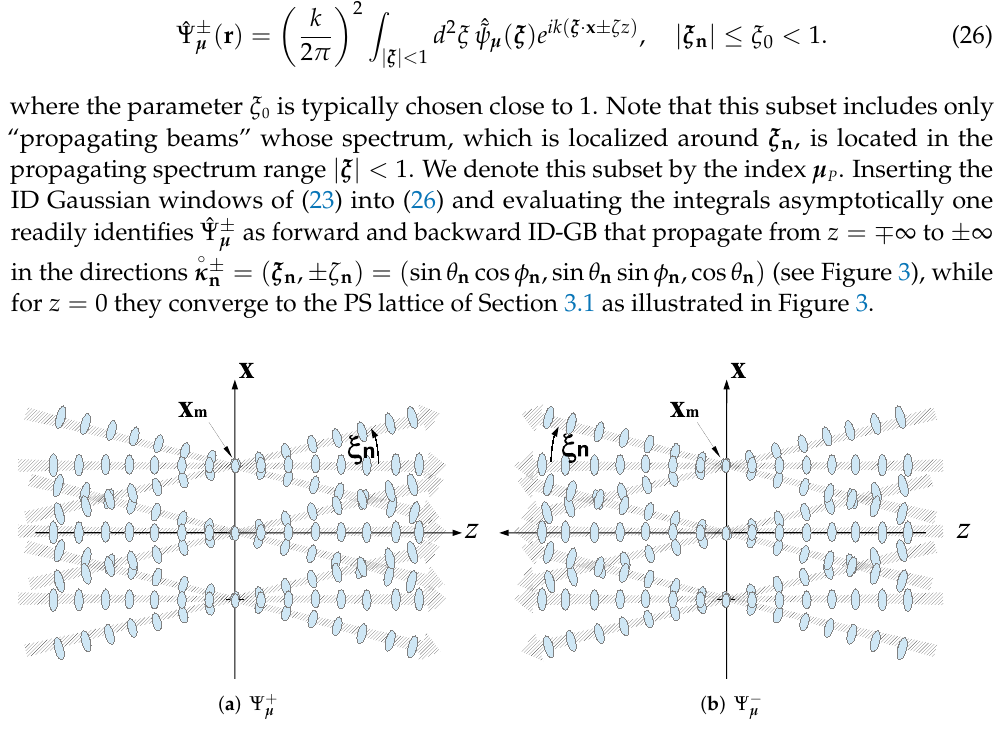
(cid:8) ˆ Ψ ± ( r ) (cid:9) µ µ P